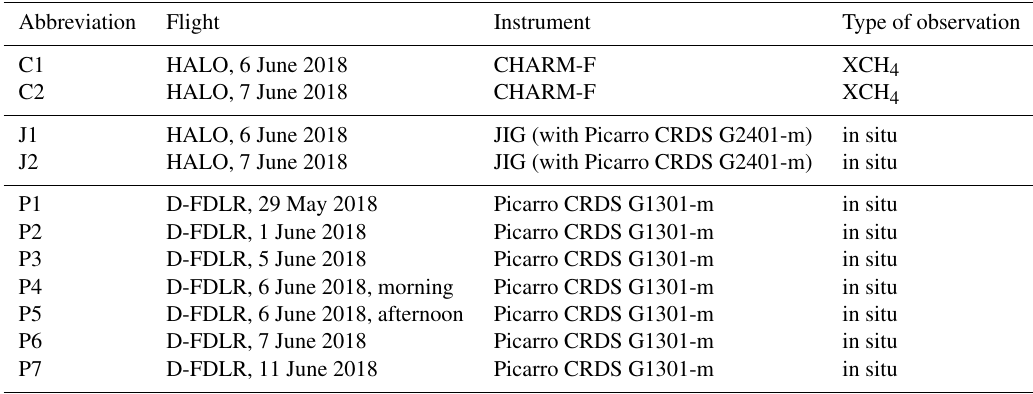
Figure 5. Chronology of the analysis simulation (dark grey) and the branching of the forecasts (FC, blue). The analysis simulation continues as soon as the ECMWF operational analysis data (two time steps ahead) are available for nudging. The required nudging time steps are indicated by the dotted lines in grey and green. A forecast simulation is branched (blue dots) every 12h from the analysis at 00:00 or 12:00 and simulates a time period of 6d. The initial conditions are provided by restart files of the analysis simulation. Table 1. Overview of the abbreviations for all observational methane data